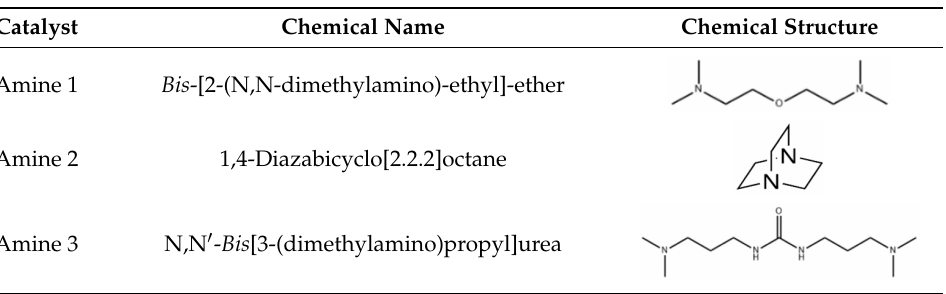
Table 2. Amine catalysts used in this